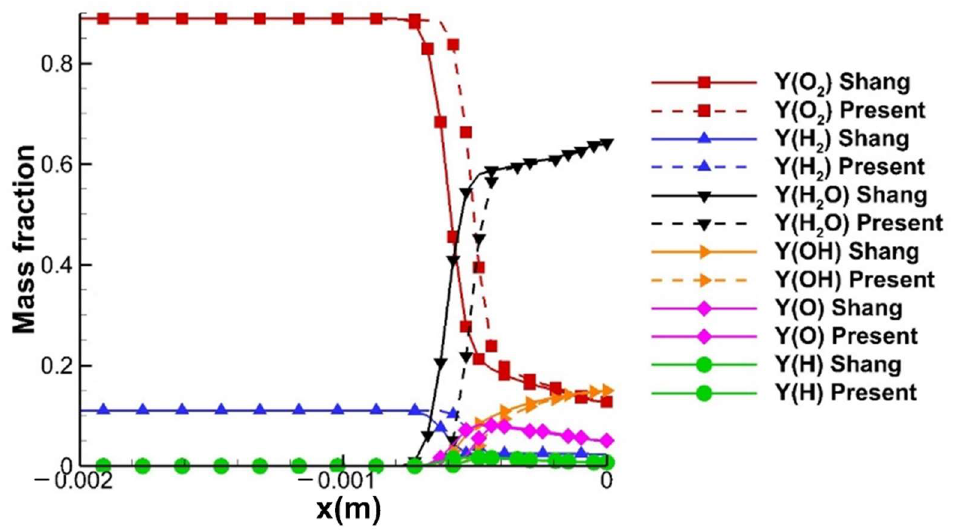
Figure 14. Mass fraction of hydrogenous and oxygenous species distribution along the stagnation line of the sub-detonative combustion.